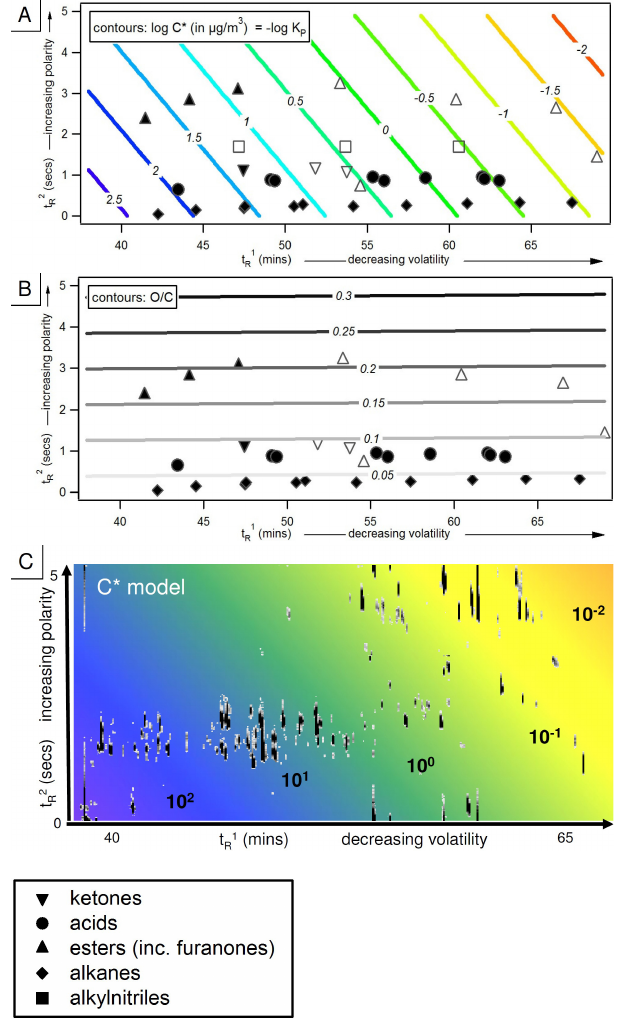
Fig. 3. (A) Effective saturation concentration C ∗ -fit based on known compounds. (B) O/C-fit based on known compounds. (C) C ∗ -fit applied to TAG #3: color scale matches (A) above. Filled markers are standard compounds, open markers are confi- dently identified in ambient data. Compounds represent classes rel- evant to ambient aerosols and are listed in full in the Supplementary